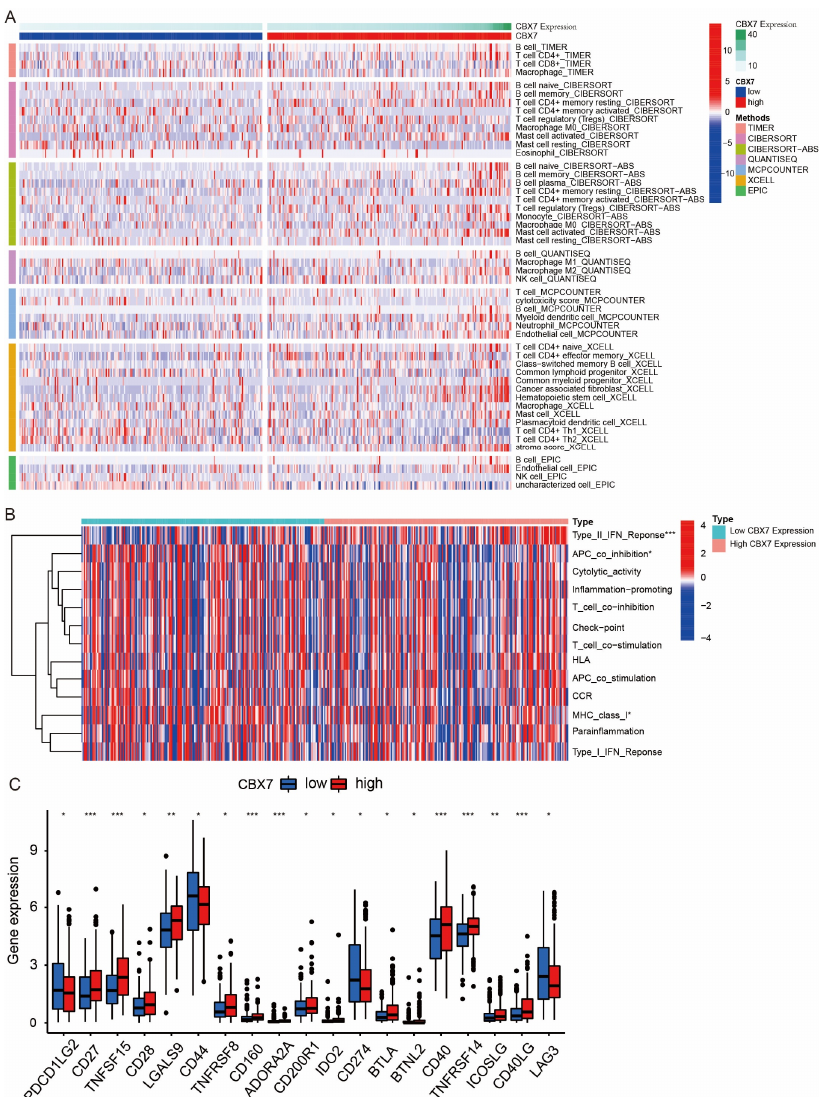
Figure 9. Immune cell infiltration of CBX7 in BLCA patients. ( A ) TIMER, CIBERSORT, CIBERSORTAB, QUANTISEQ, MCPCOUNTER, XCELL, and EPIC algorithms for the immune cell infiltration landscape in the high- and low-risk groups (blue: low CBX7 expression; red: high CBX7 expression). p < 0.05 was enforced to ensure that only items with statistically significant differences were reported. ( B ) ss GSEA scores for immune cells and immunological function for groups with high vs. low CBX7 expression vs. low CBX7 expression. ( C ) Variations in the expression of common immune checkpoints between CBX7 high- and low-expression groups. * p < 0.05; ** p < 0.01; *** p < 0.001. The CIBERSORT method was used to quantify the proportion of immune-related subgroups that infiltrated tumors. Consequently, the association between CBX6 and the immunological milieu may be elucidated further, and 21 immune cell profiles were also generated from BLCA data. Five types of immune cells had clearly distinct expression